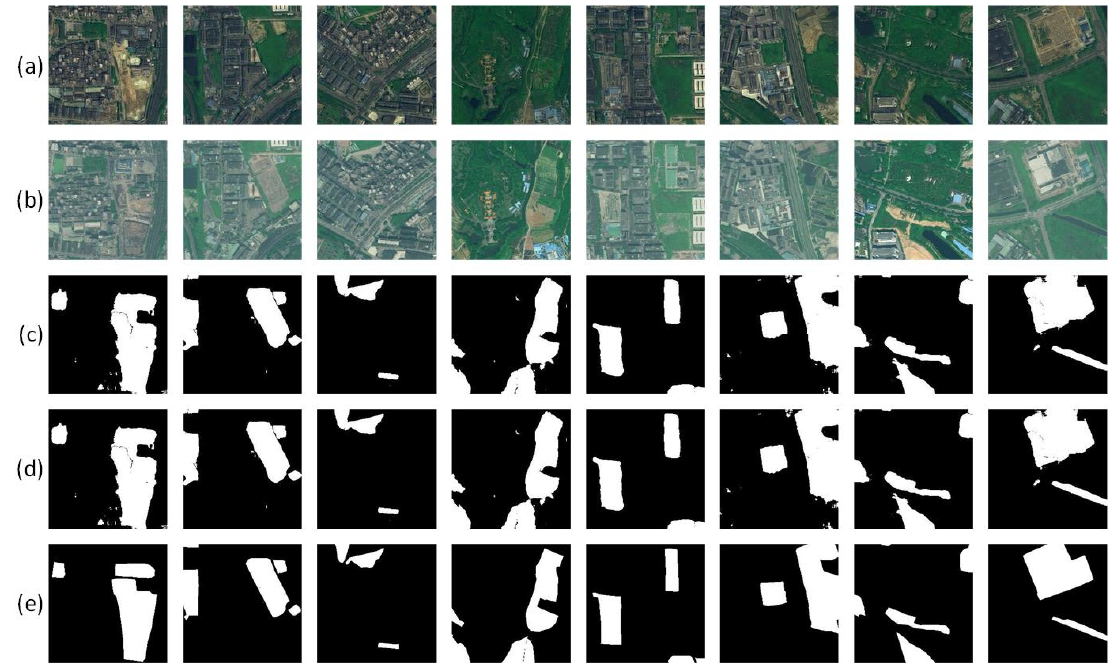
Figure 11. The representative change detection results affected by diverse detectors: ( a ) image 1, ( b ) image 2, ( c ) the changes detected by separate training, ( d ) the changes detected by weights shared training, ( e ) reference map.